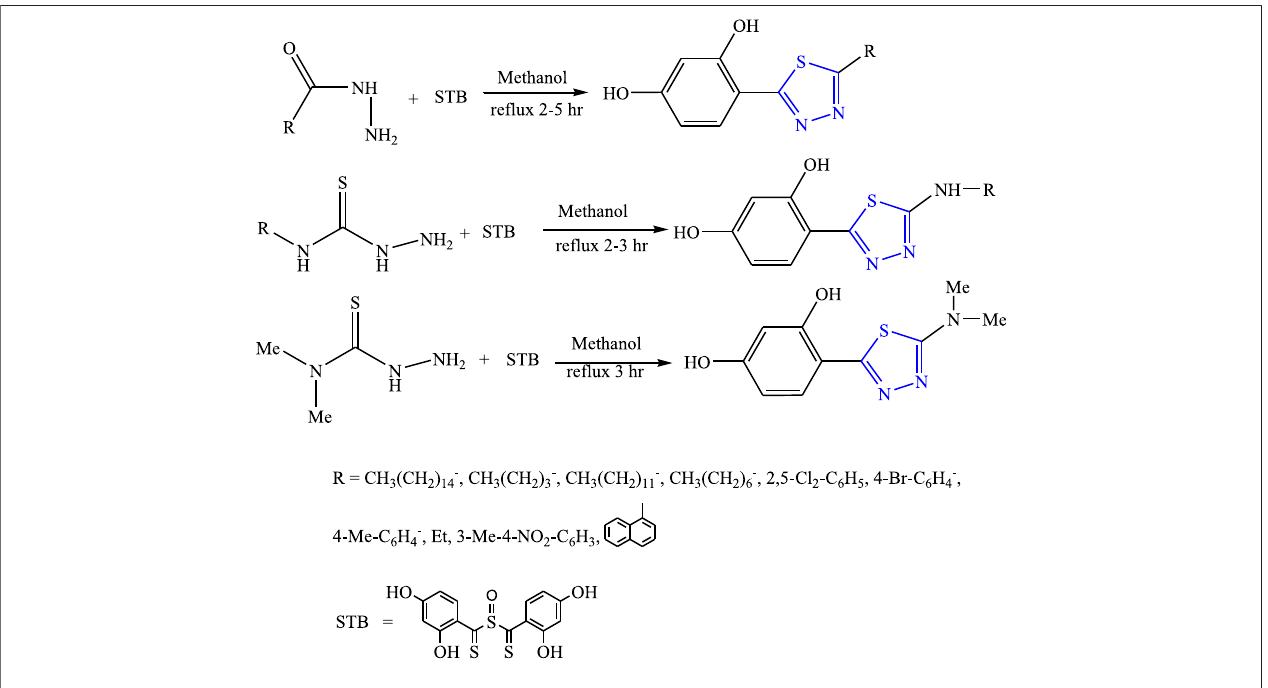
FIGURE 11 | Synthetic pathway for designing thiosemicarbnyl/hydrazide derivatives of 1,3,4-thiadiazole.